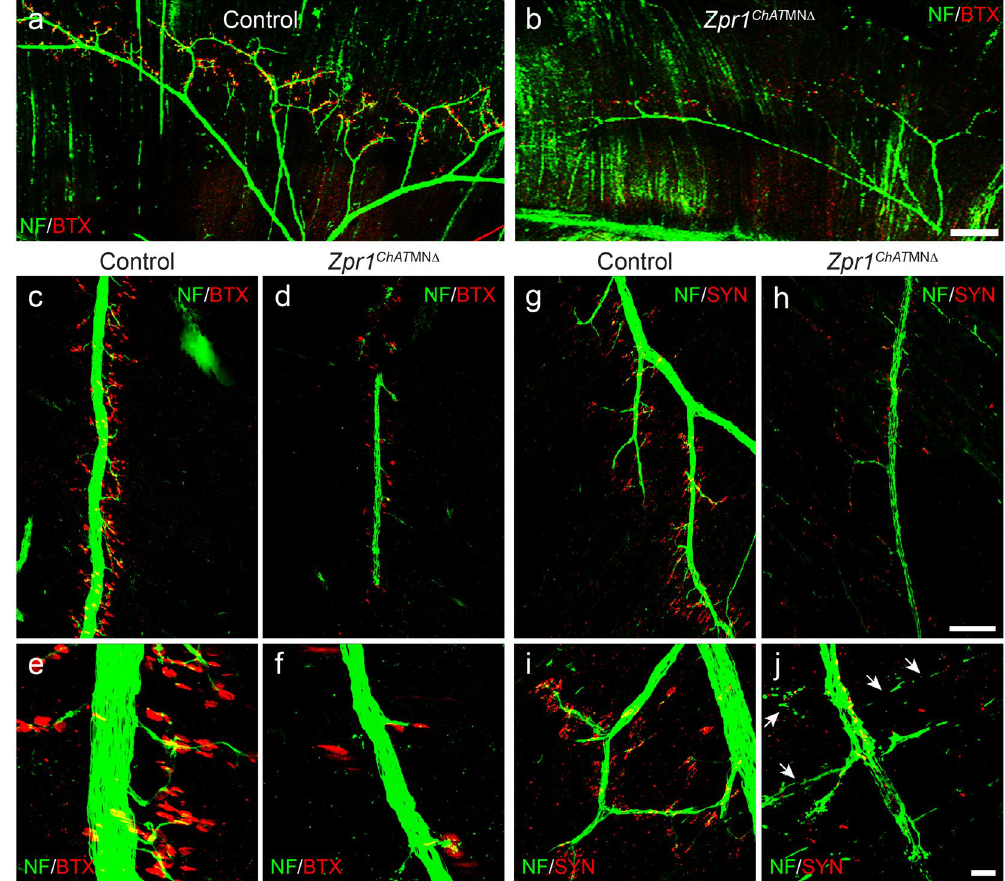
Figure 6. Temporal delay in Zpr1 mutation causes phrenic nerve degeneration and defects in synapse formation in Zpr1 ChAT MN Δ mice. ( a , b ) Whole diaphragms from control and Zpr1 ChAT MN Δ E18.5 embryos were stained with neurofilament (NF) antibody and α -bungarotoxin (BTX). Image analysis show defects in branching of the phrenic nerve in Zpr1 ChAT MN Δ embryos. ( c – f ) Analysis of diaphragms stained with NF and BTX shows defects in the formation of NMJs in mutant embryos. Primary innervation of phrenic nerve was improved in Zpr1 ChAT MN Δ compared to Zpr1 Hb9 MN Δ mice but reduced numbers of secondary and tertiary branches were generated in Zpr1 ChAT MN Δ mice. ( g – j ) Staining of diaphragms with NF and synaptophysin (SYN) shows marked reduction in the tertiary branches and formation of neuromuscular synapses in Zpr1 ChAT MN Δ mice. Degeneration of secondary and tertiary branches was detected in mutant embryos (arrows). Lack of terminal branches and functional synapses indicate requirement of ZPR1 in motor neurons for the normal functioning of the respiratory system. Scale bars are 250 μ m ( a , b ), 100 μ m ( c , d , g , h ) and 12.5 μ m ( e , f , I , j